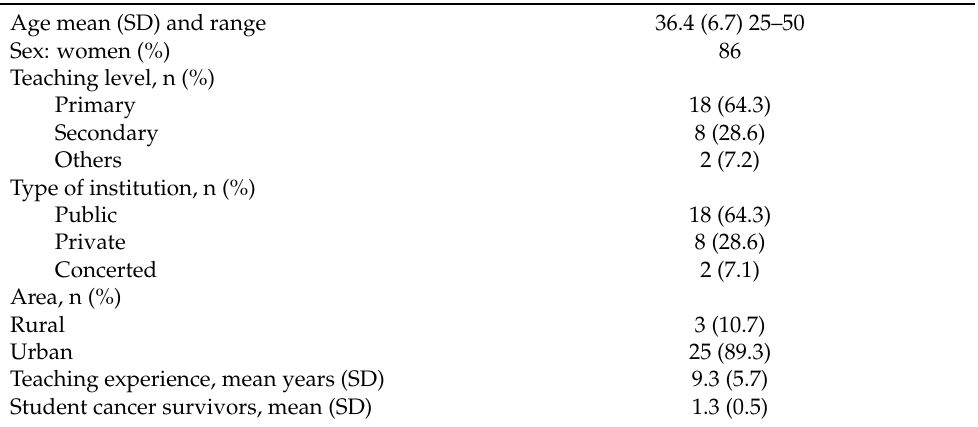
Table 1. Sample characteristics from Round I (n =